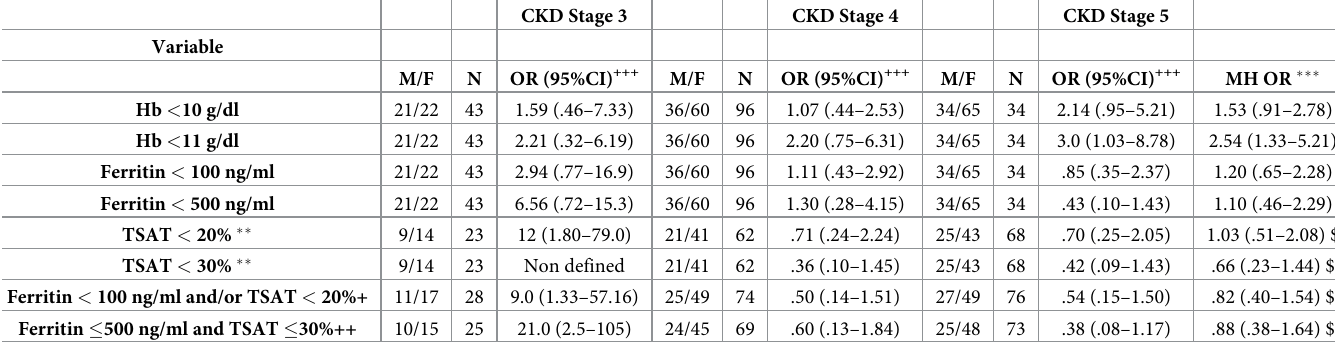
After adjustment on covariates (power transform of age and hemoglobin), INT of ferritin ranks tended to be statistically significant (p = 0.051, Table 4), mainly driven by the gender and CKD stage interaction. A similar analysis of INT of TSAT ranks showed no significant association with gender or CKD stage. Table 3. Hemoglobin and iron parameters of the 238 patients after adjusting for CKD